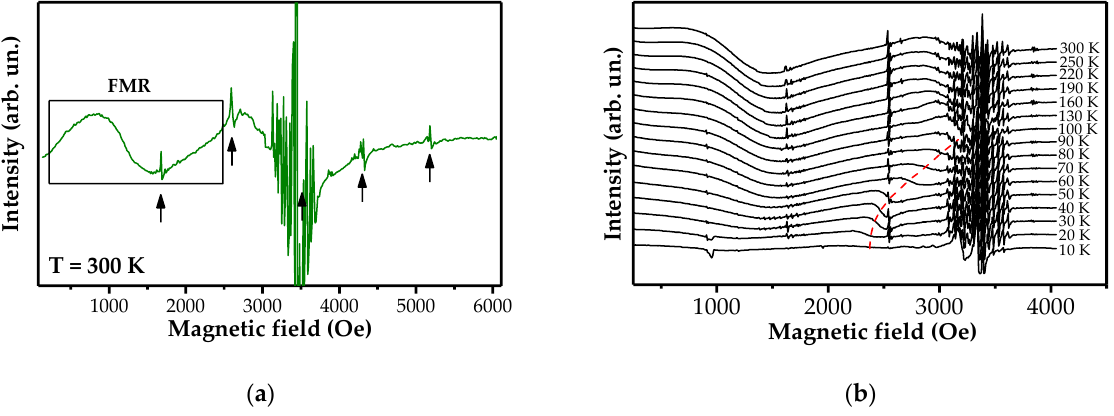
Figure 4. In-plane magnetic resonance spectrum of Fe-ion-implanted MgO: ( a ) at room temperature; ( b ) temperature evolution of the spectrum in the range of 10 – 300 K. Here main FMR line related to α -Fe particles is highlighted by rectangle. The arrows show fine structure components of EPR tetragonal-symmetry Cr 3+ -ion centers, and red dash line shows a position of broad FMR line originated from the magnesium ferrite clusters.